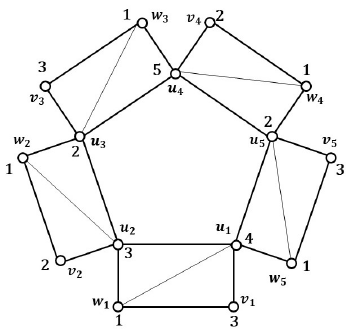
Figure 1. An origami graph O 5 .